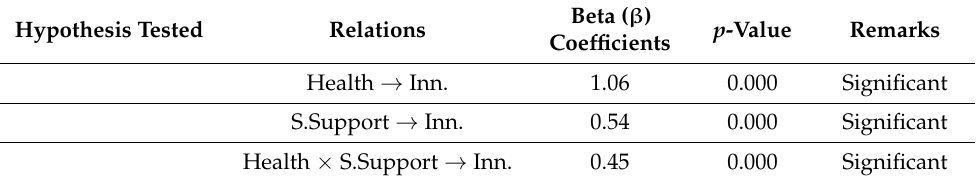
Table 9. Moderated behavior of supervisor support between health and innovative work behavior.